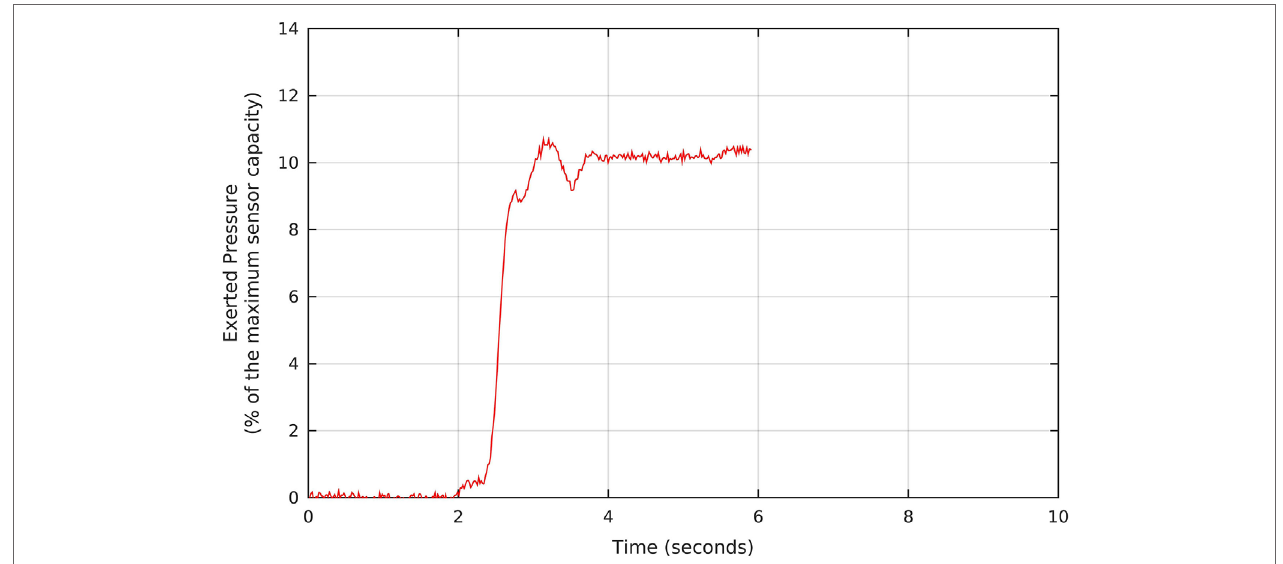
FIgURe 3 | Example of pressure signal measured during the pressure taring, which precedes the biofeedback protocols. The Neurodyn Evolution screen shows the maximum voluntary contraction that each volunteer manages to apply to the anal probe (in this example, around 10% of the maximum sensor capacity). The procedure is repeated for a total of three times, and we take the maximum MVC, and use it as a reference for defining the target pressure during the biofeedback